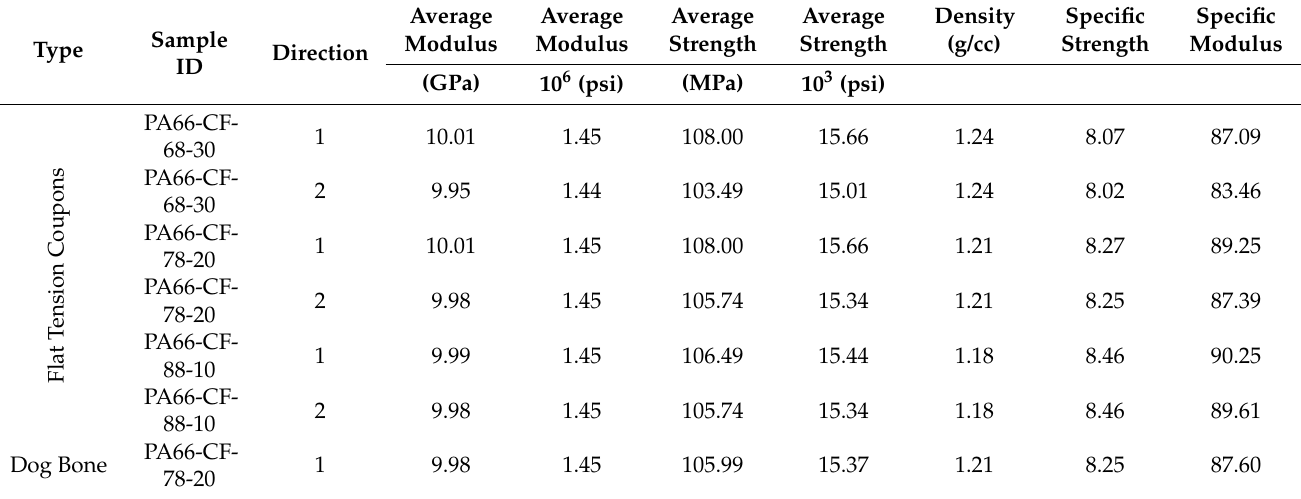
Table 3. Tensile modulus and strength of C/PA66 (preform ‘Sheets’).